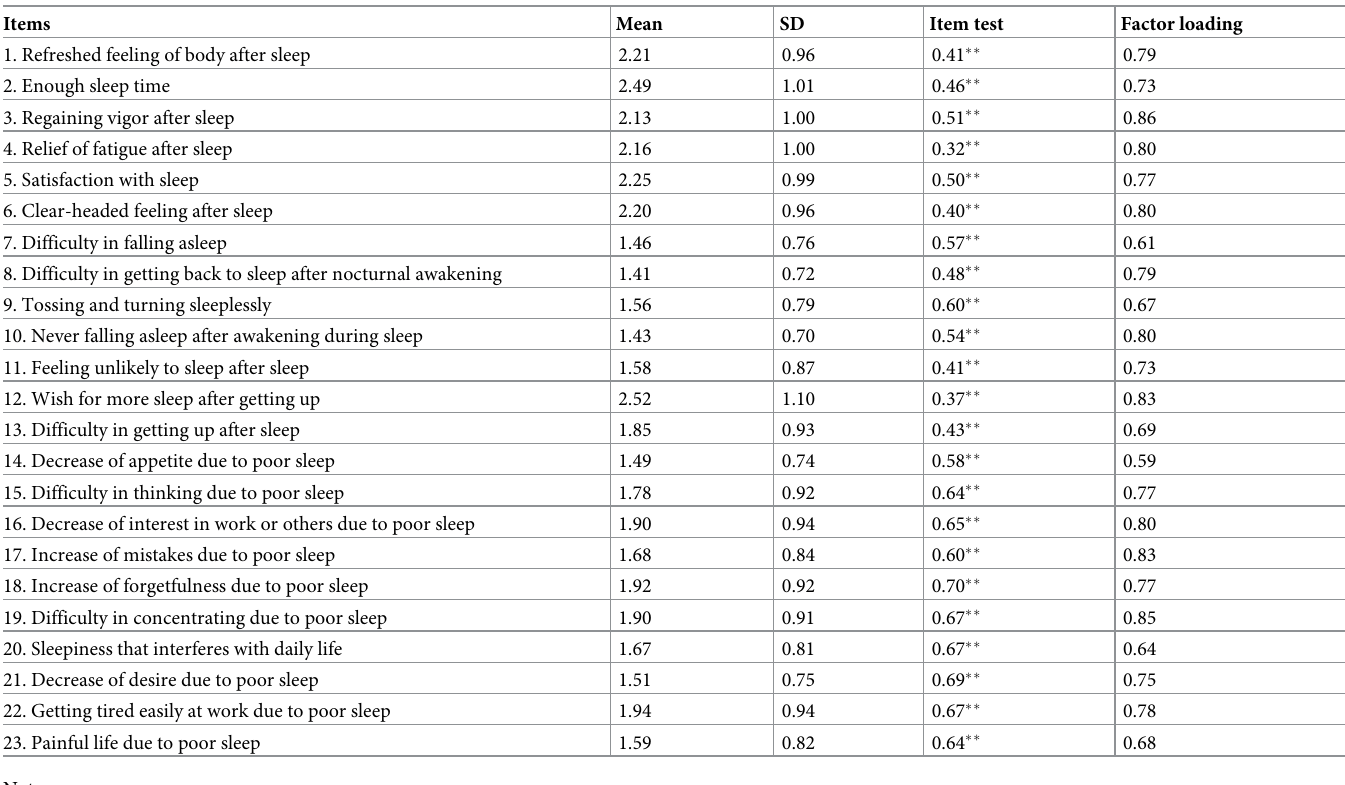
Table 2. Descriptive statistics of SQS-C items ( n =